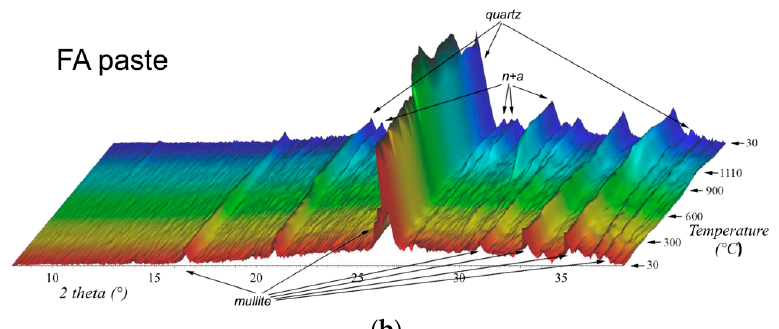
Figure 10. High-temperature XRD patterns for MK paste ( a ) and FA paste ( b ) measured in the temperature range of 30–1200 °C (n + a = nepheline + albite).